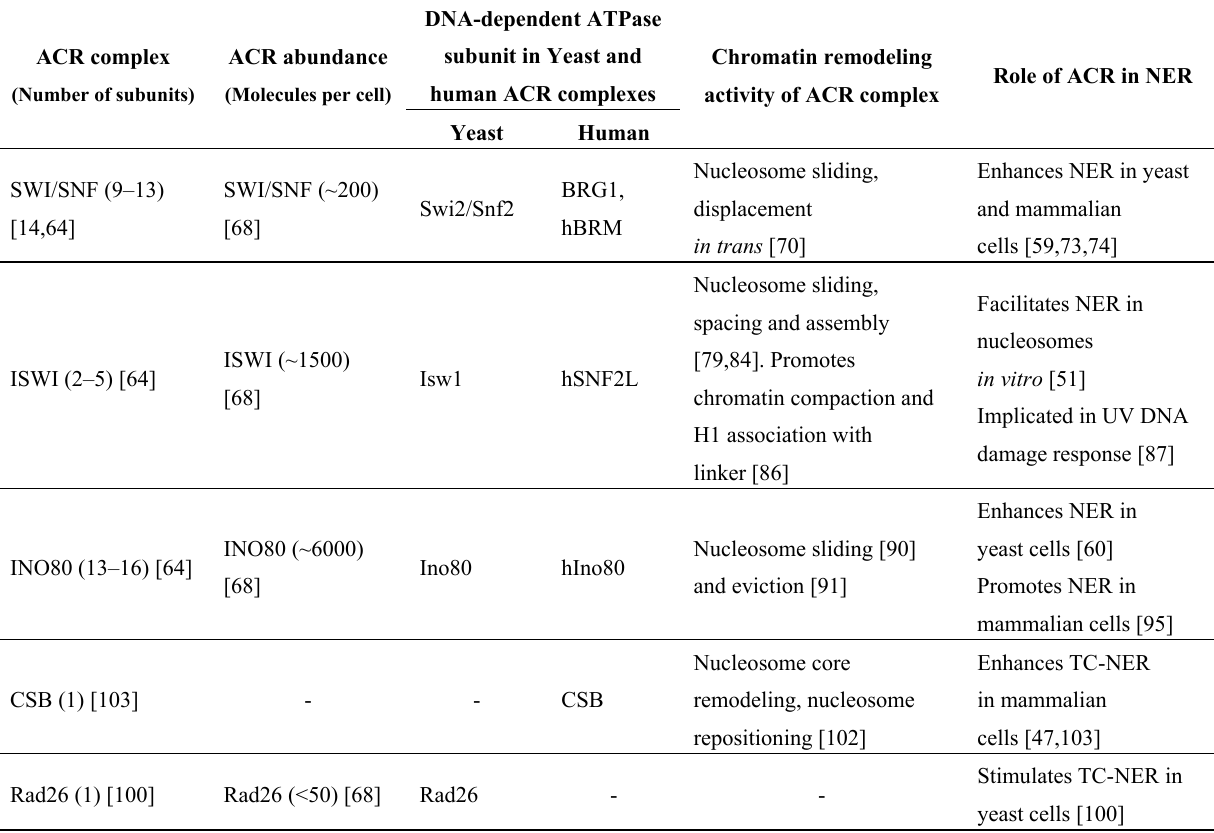
Table 1. ATP-dependent chromatin remodeling enzymes involved in